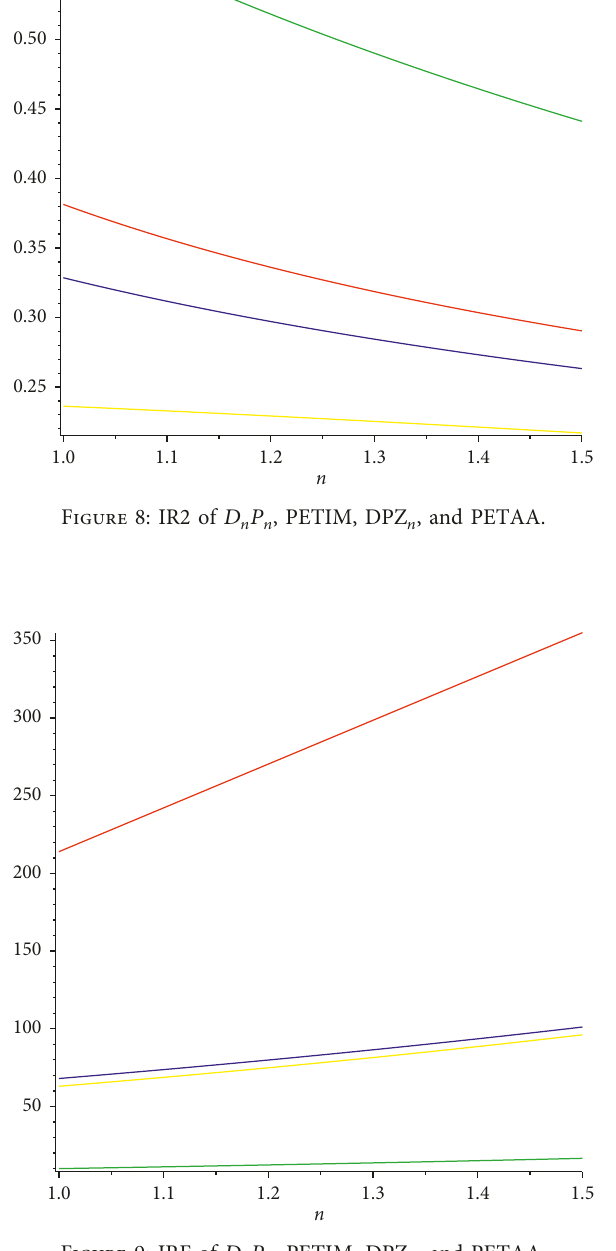
P n n , PETIM, DPZ n , and PETAA.